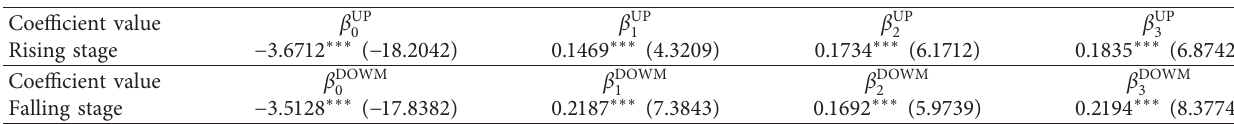
Table 6: Empirical test results of rising stage and falling stage.